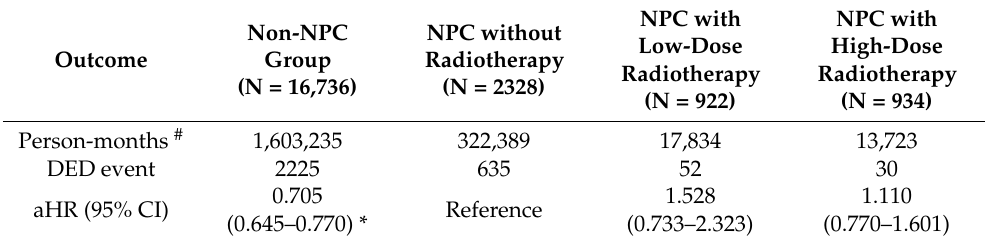
Table 4. Outcomes for the patients with nasal pharyngeal carcinoma stratified by radiotherapy and individuals without nasal pharyngeal carcinoma.